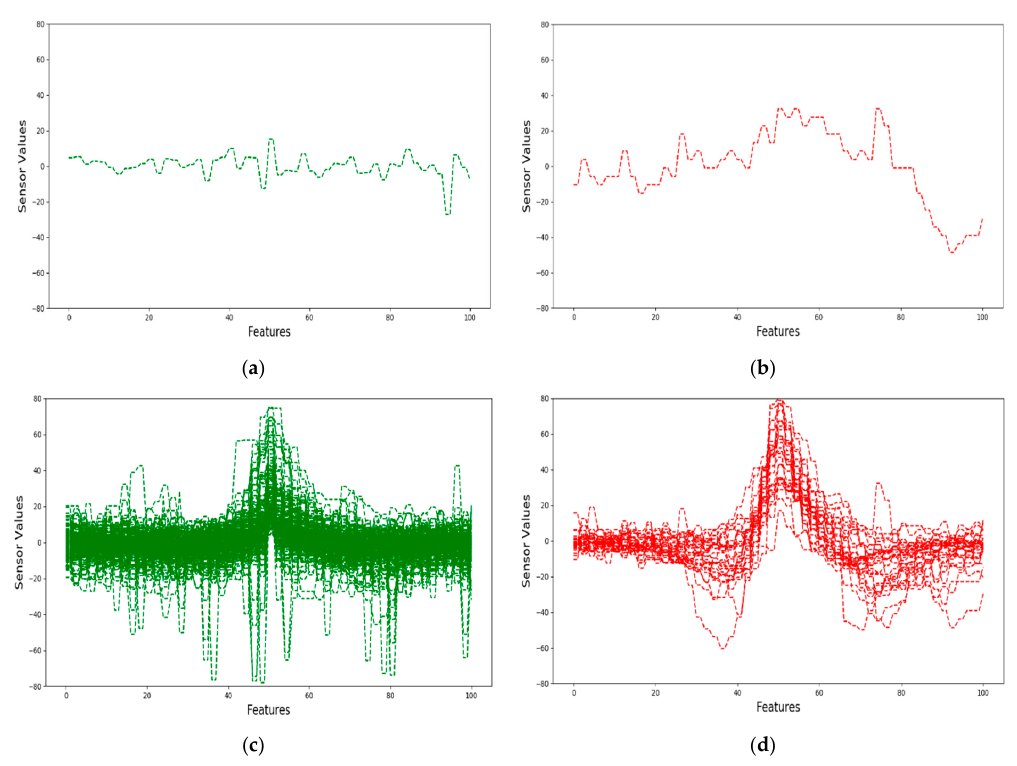
Figure 3. ( a ) A safe signal; ( b ) a crack signal; ( c ) safe signals; and, ( d ) crack signals.